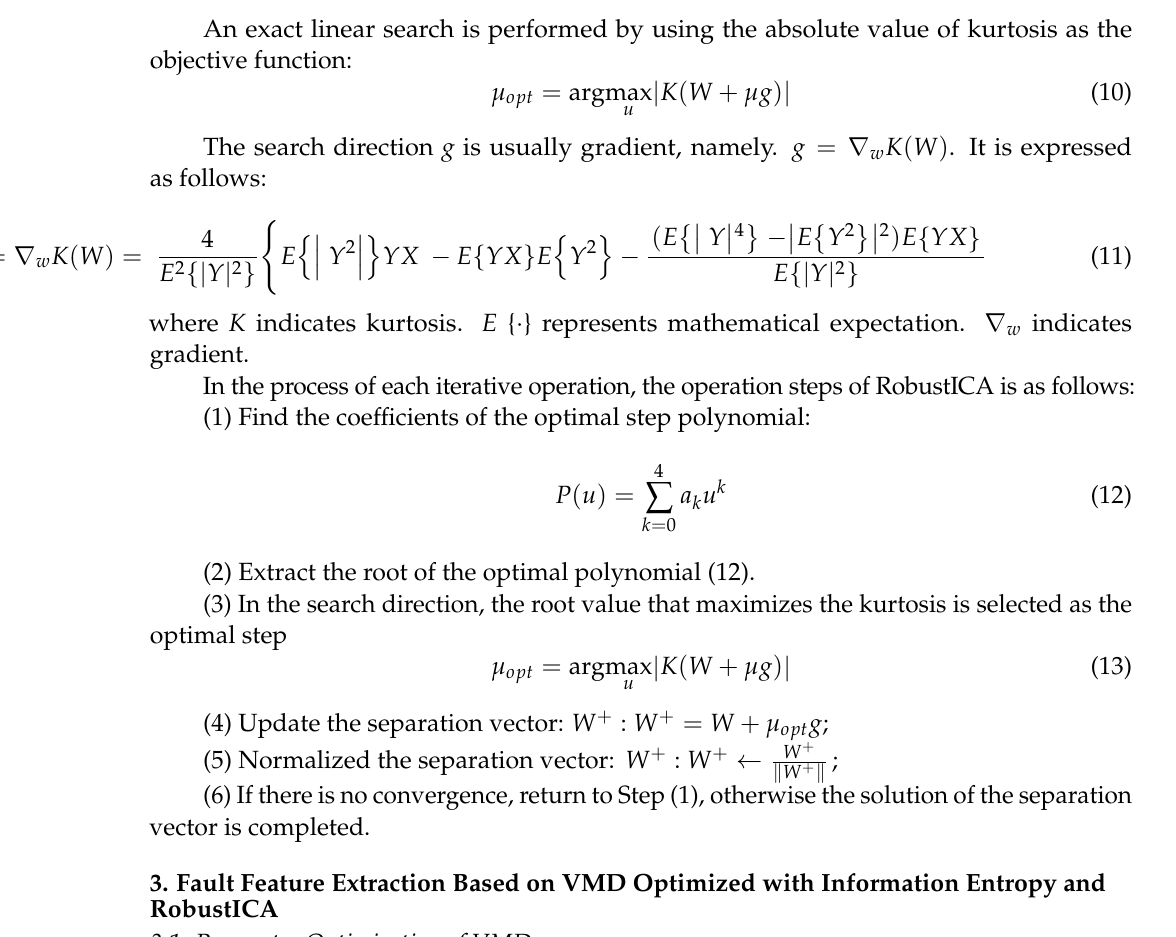
Figure 1. Frame of independent component